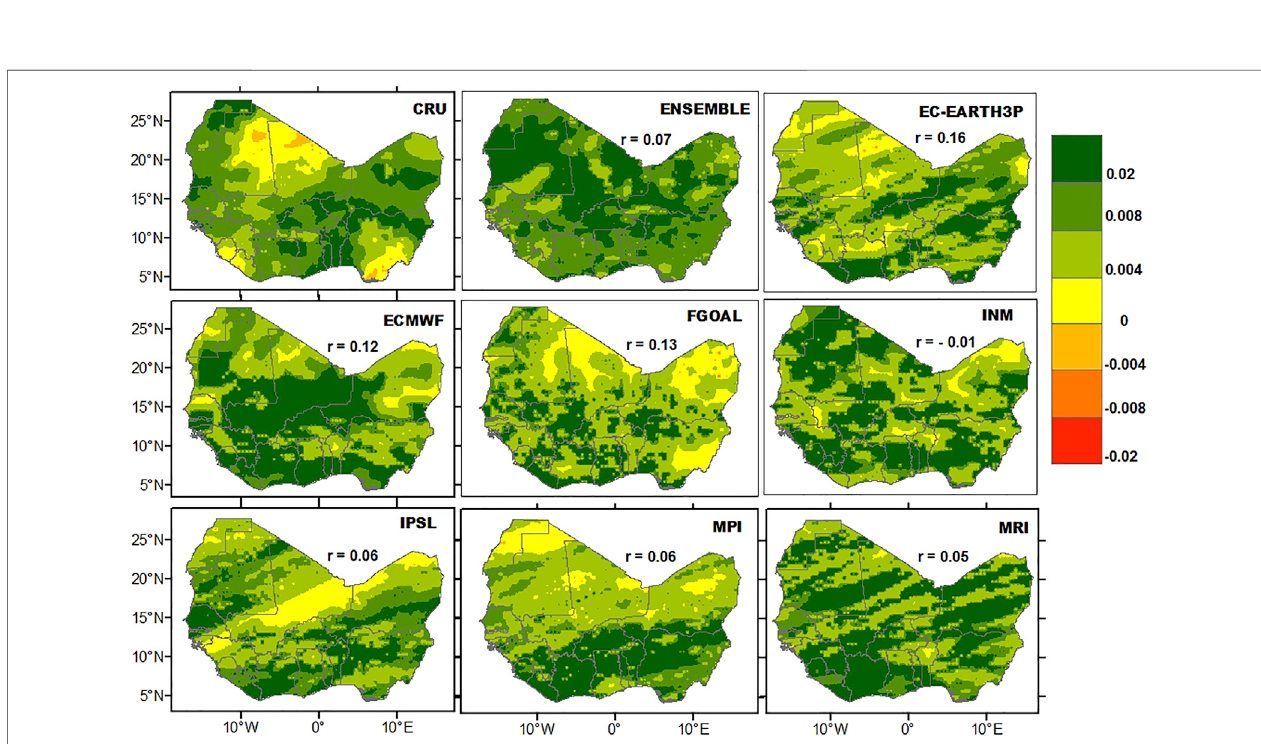
FIGURE5| Observedandsimulatedclimatologicaldistributionofstandardizedevapotranspirationindex1(SPEI-1)overWestAfricaduring1985 – 2014.rindicates the Pearson pattern correlation between the observation and each HighResMIP simulation.